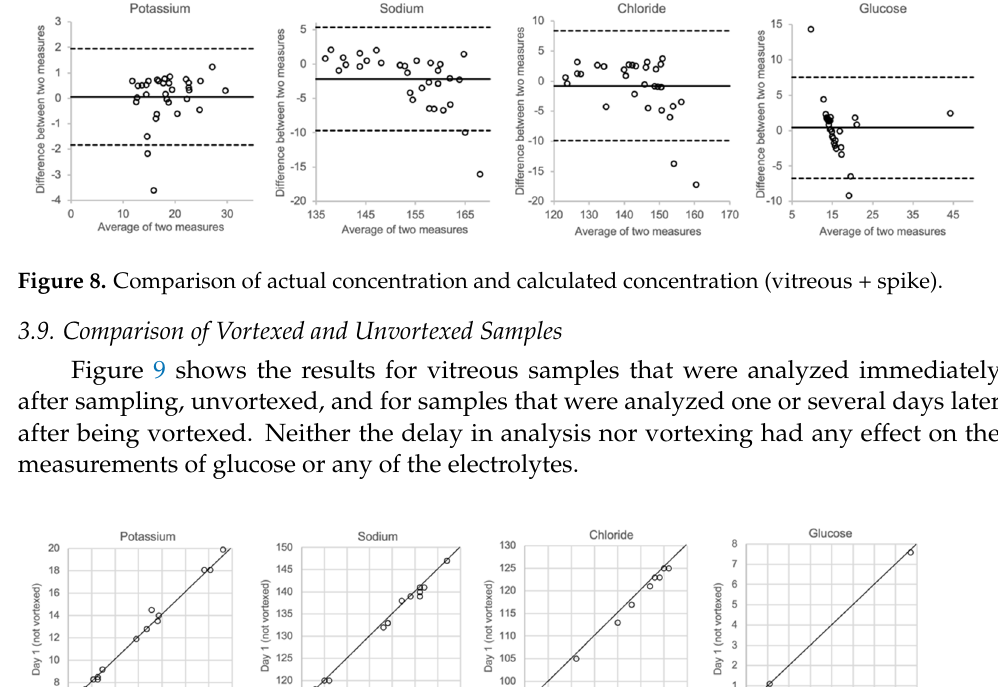
9 of 13 Figure 7. Comparison of samples taken from center of the right and left eye, n = 16. 3.8. Spike Test